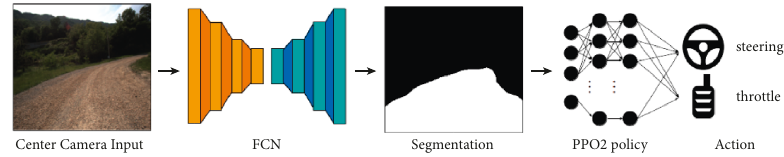
Figure 2: Pipeline of our method used in inference